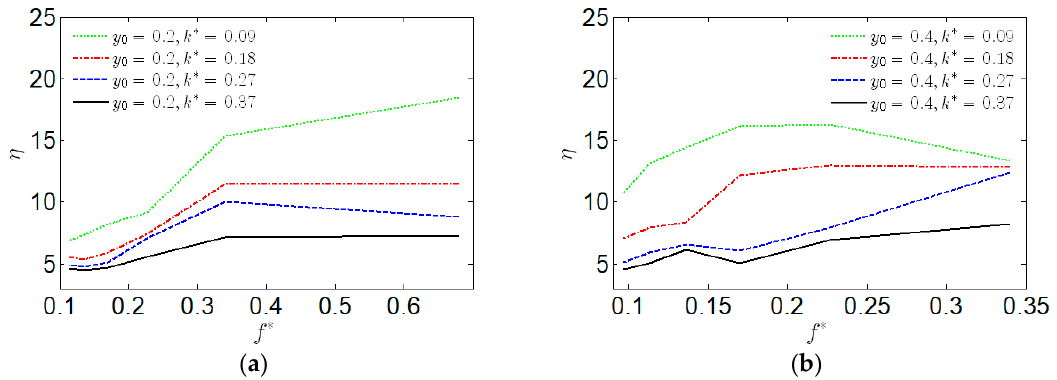
Figure 8. Comparison of the propulsive efficiency for varying reduced frequencies, ( a ) 𝑦 (cid:2868) = 0.2 and ( b ) 𝑦 (cid:2868) = 0.4 .